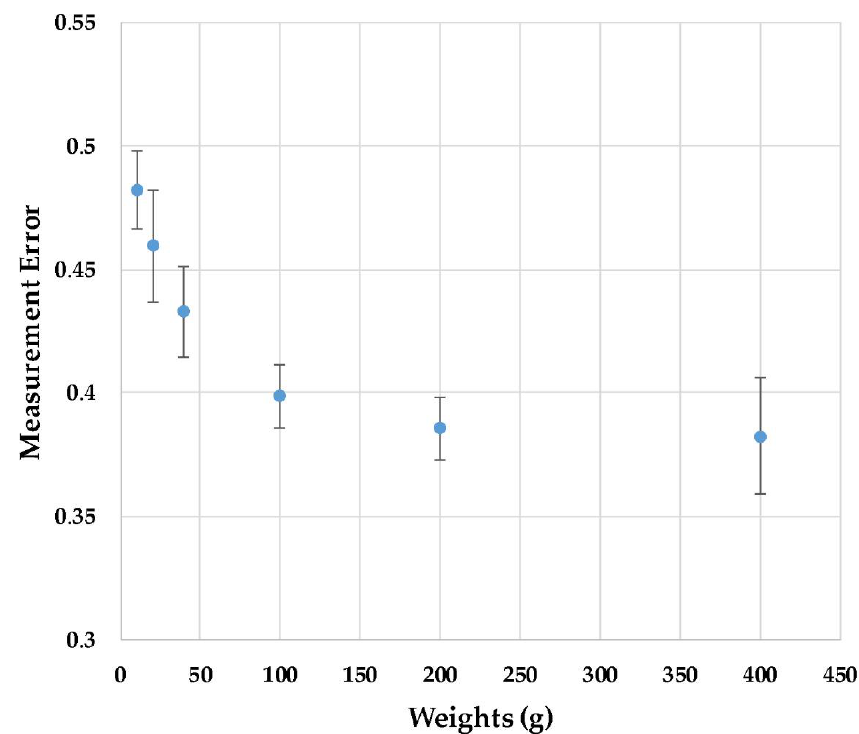
Figure 7. The change in the measurement error between the rigid surface (soldering iron shaft) temperature and the temperature sensing yarn when different weights were attached to the temperature sensing yarn, varying the contact pressure between the yarn and the shaft.